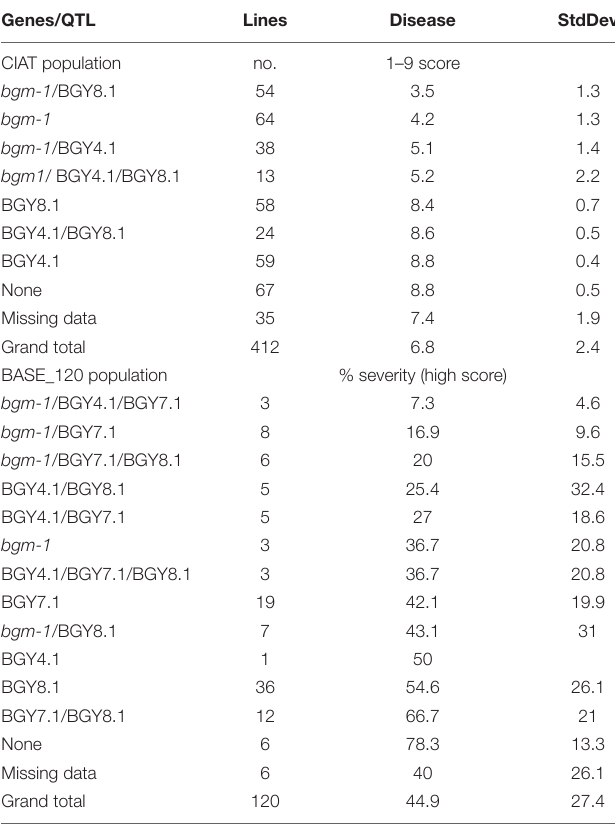
TABLE 5 | Mean effect of bgm-1 (PvNAC1) and QTL-linked markers for BGY4.1 (S04_2531038), BGY7.1 (1143_407) a , and BGY8.1 (S08_9202267) on disease reaction in two